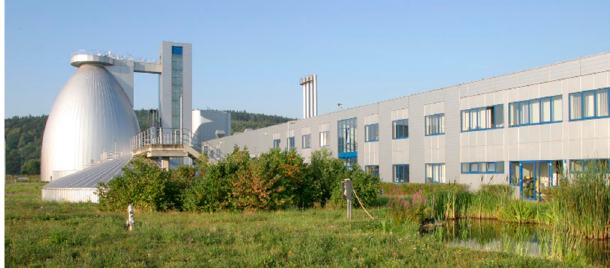
Figure 4. Energy-autonomous WWTP in Gera, Germany [33].